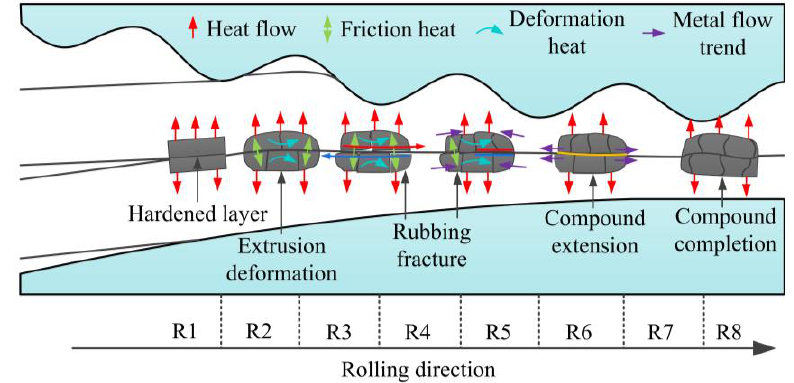
Figure 15. Schematic diagram of interface bonding during the corrugated rolling process [28].